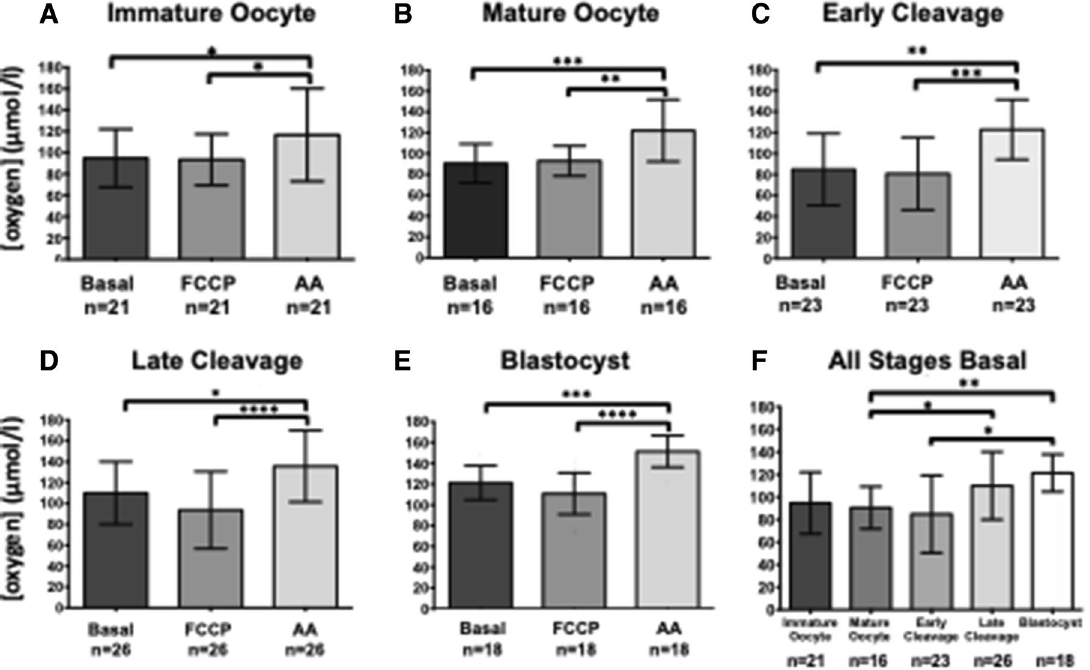
Figure 3. icO 2 throughout preimplantation development. Effect of FCCP and antimycin treatment on icO 2 of ( A ) immature oocytes (n = 21) Basal (94.76 ± 27.28 µmol/l), FCCP treated (93.39 ± 24.06 µmol/l) and antimycin treated (116.6 ± 43.59 µmol/l); ( B ) mature oocytes (n = 16) Basal (90.56 ± 18.73 µmol/l), FCCP treated (92.97 ± 14.46 µmol/l) and antimycin treated (122.1 ± 29.73 µmol/l); ( C ) EC embryos (n = 23) Basal (84.84 ± 34.37 µmol/l), FCCP treated (80.78 ± 34.66 µmol/l) and antimycin treated (122.90 ± 28.60 µmol/l); ( D ) LC embryos (n = 26) Basal (110.1 ± 30.03 µmol/l), FCCP treated (93.73 ± 36.91 µmol/l) and antimycin treated (135.70 ± 34.14 µmol/l); ( E ) Blastocysts (n = 18) Basal (121.4 ± 16.51 µmol/l), FCCP treated (110.0 ± 20.03 µmol/l) and antimycin treated (151.40 ± 15.16 µmol/l); ( F ) Basal icO 2 comparison between immature oocyte, mature oocyte, EC embryo, LC embryo and blastocyst stages. Values plotted as mean ± SD for the number of analyses shown * p < 0.05, ** p < 0.01, *** p < 0.001 and **** p <